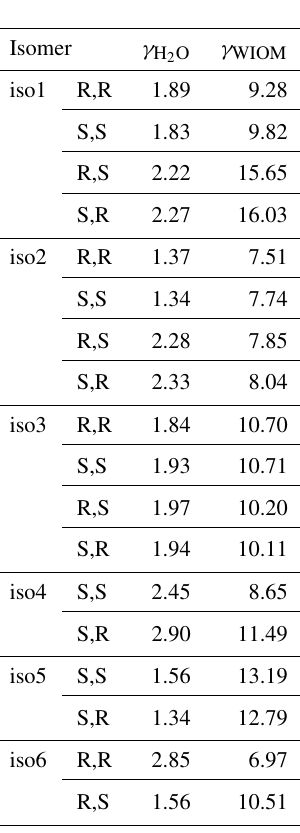
Table 2. Activities of ISOP ( OOH ) 2 species computed in water and in a water-insoluble organic-phase model (WIOM) compound “Kalberer molecule B” (Kalberer et al., 2004), at infinite dilution and at 298.15 K, calculated using COSMOtherm version 18 and the BP_TZVPD_FINE_18 parameterization (based on BP/def2- TZVPD//BP/def-TZVP quantum chemical data). γ Isomer γ H 2 O